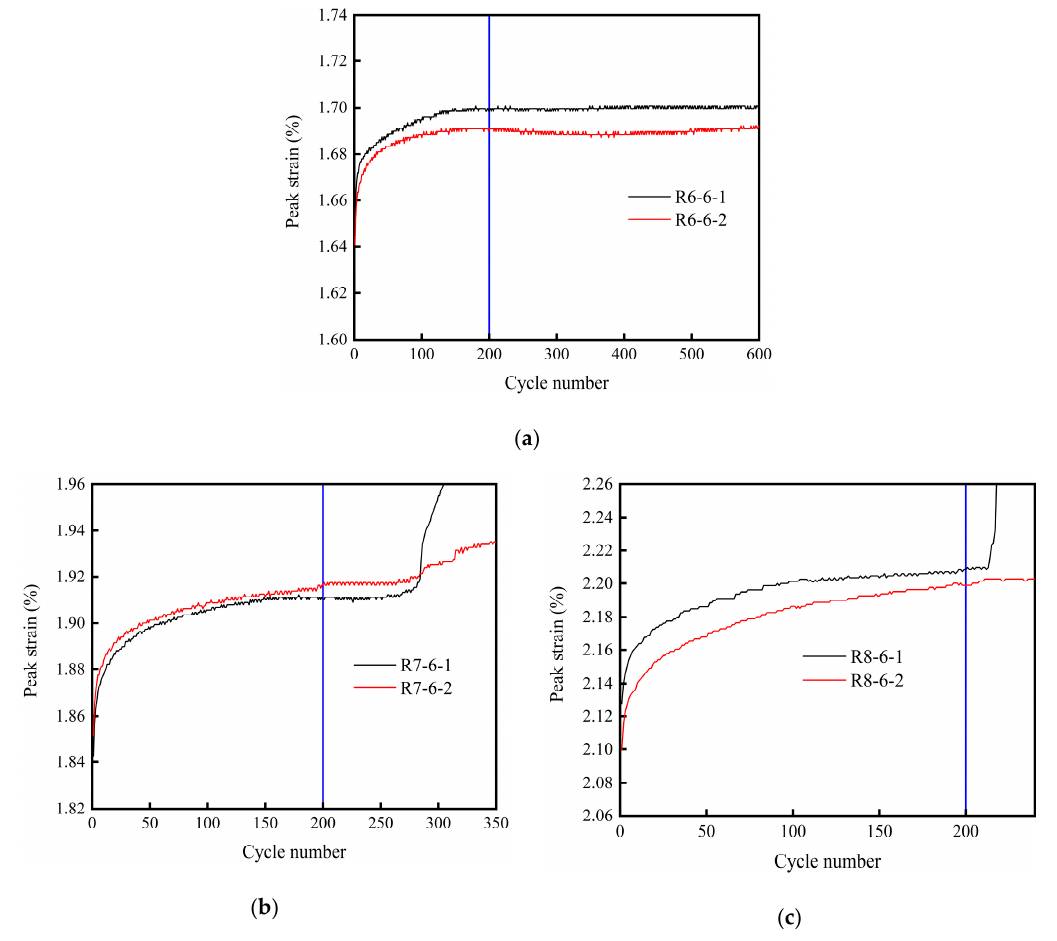
Figure 11. The relationship between the cyclic loading and unloading peak strain and cycle number when the stress upper limit is ( a ) 60%, ( b ) 70%, and ( c ) 80% of σ c .